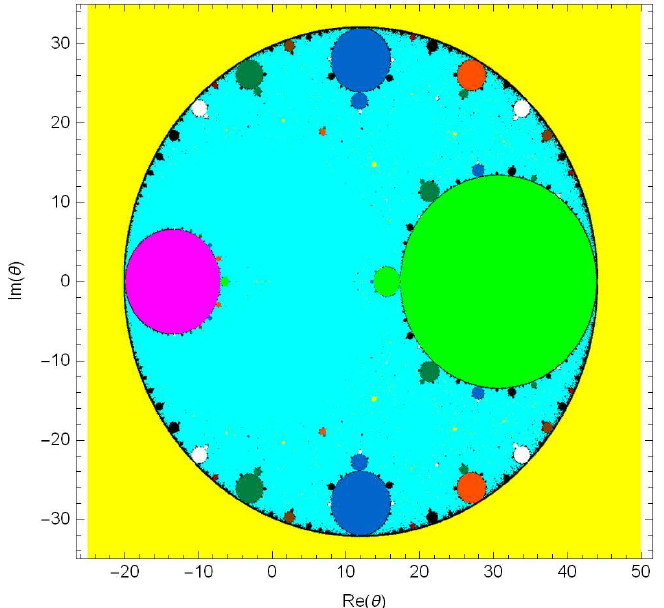
Figure 6. Parameter plane associated with the free critical point fcr 1 ( θ )